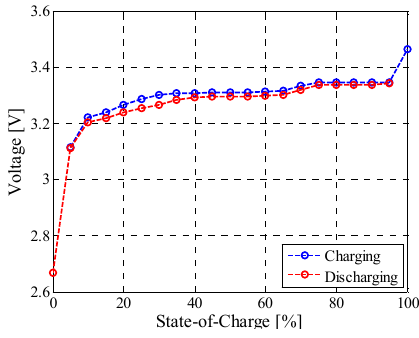
Figure 5. The OCV - SOC characteristic of the LFP/C battery measured at 25 °C.